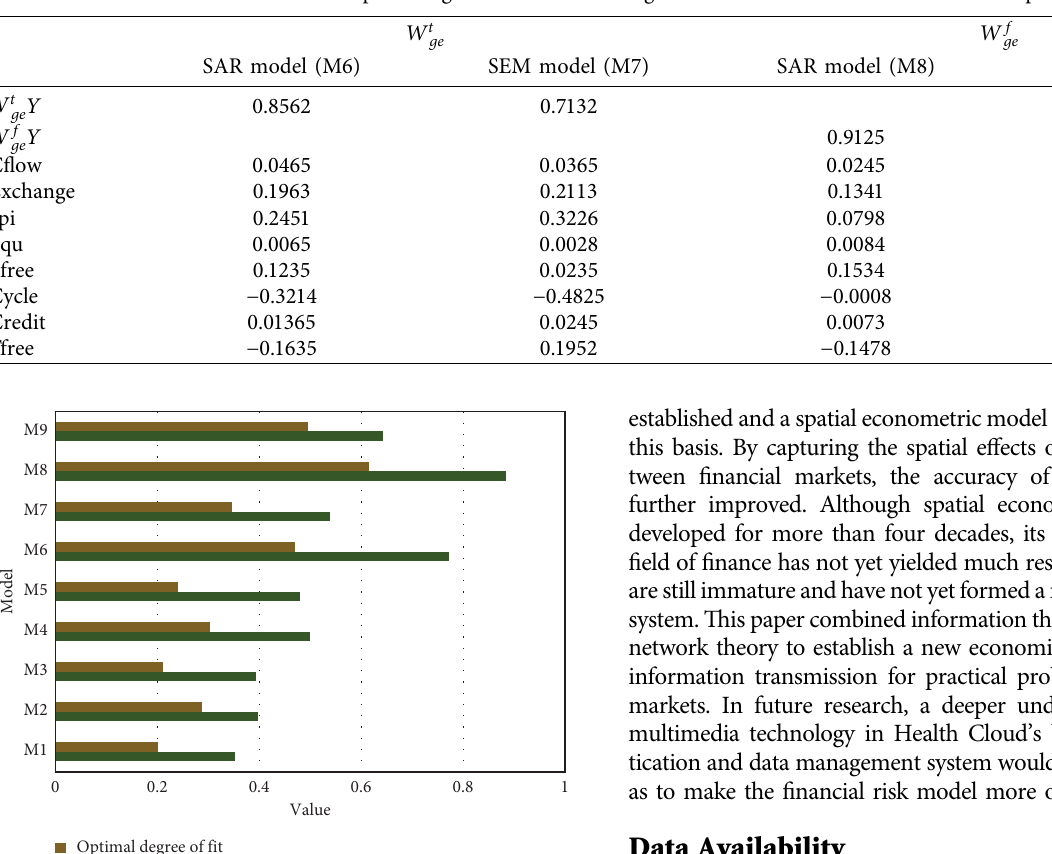
Table 7: Gravitational space weights matrix model in generalized multidimensional economic space.